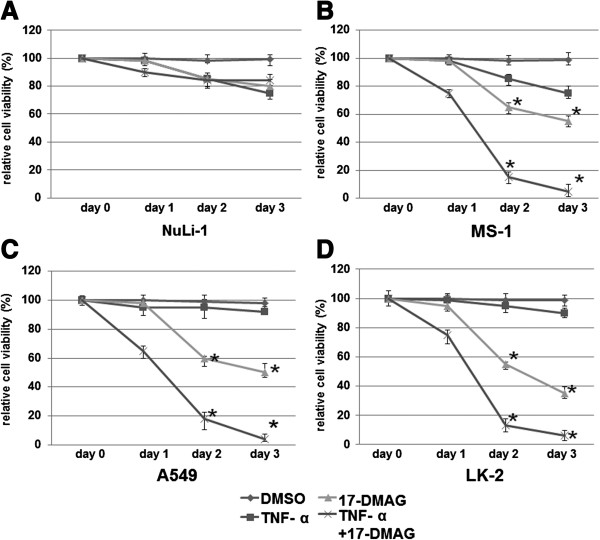
Cell treatments with DMSO, TNF-α, 17-DMAG, or TNF-α and 17-DMAG together. The normal human bronchial epithelium cell line (NuLi-1) and three lung cancer cell lines (MS-1, A549, and LK-2) were treated with either vehicle control (DMSO), TNF-α (10 ng/ml), 17-DMAG (0.05 μM), or both. Cell counts in each condition were determined by trypan blue exclusion at the time points indicated. (A) NuLi-1 cells; (B) MS-1 cells; (C) A549 cells; (D) LK-2 cells. Cell viability was measured using 3-(4,5-dimethylthiazol-2-yl)-2,5-diphenyltetrozolium bromide (MTT) assay immediately before (day 0) and after 1, 2, or 3 days of incubation with the drugs. Values are means ± SD for three experiments. It is considered not significant, when P > 0.05 vs. control (DMSO) cell viability of each treatment. *, it is considered as a significant difference, when P < 0.05 vs. corresponding control.